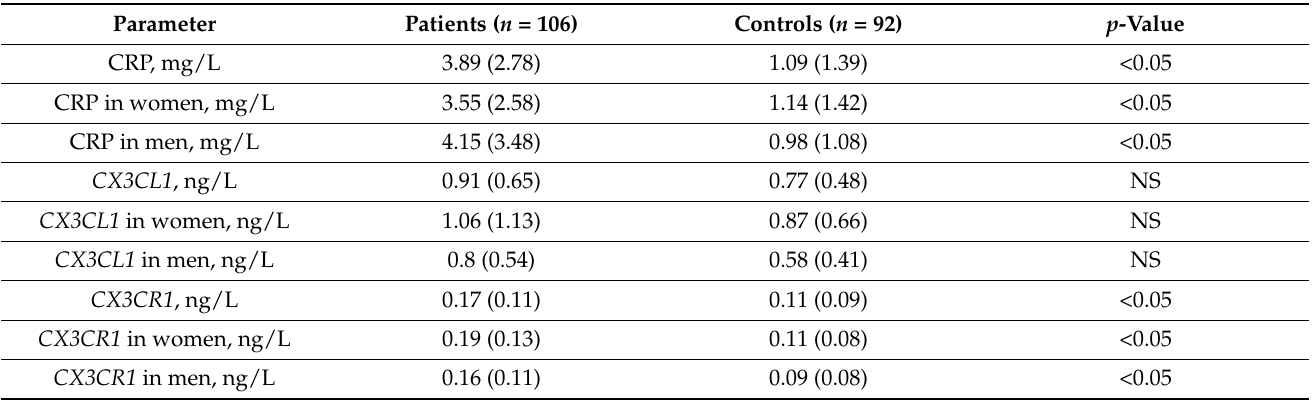
Table 3. Differences in C-reactive protein (CRP), CX3CL1 , and CX3CR1 levels between patients with end-stage renal disease and controls in general and separately for women and